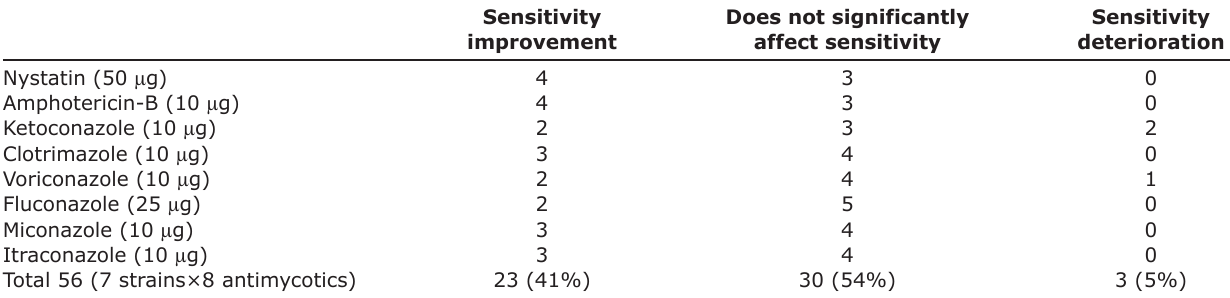
Table-9: Summary table of mathematical calculations of the effect of farnesol to the Candida albicans sensitivity to antifungal